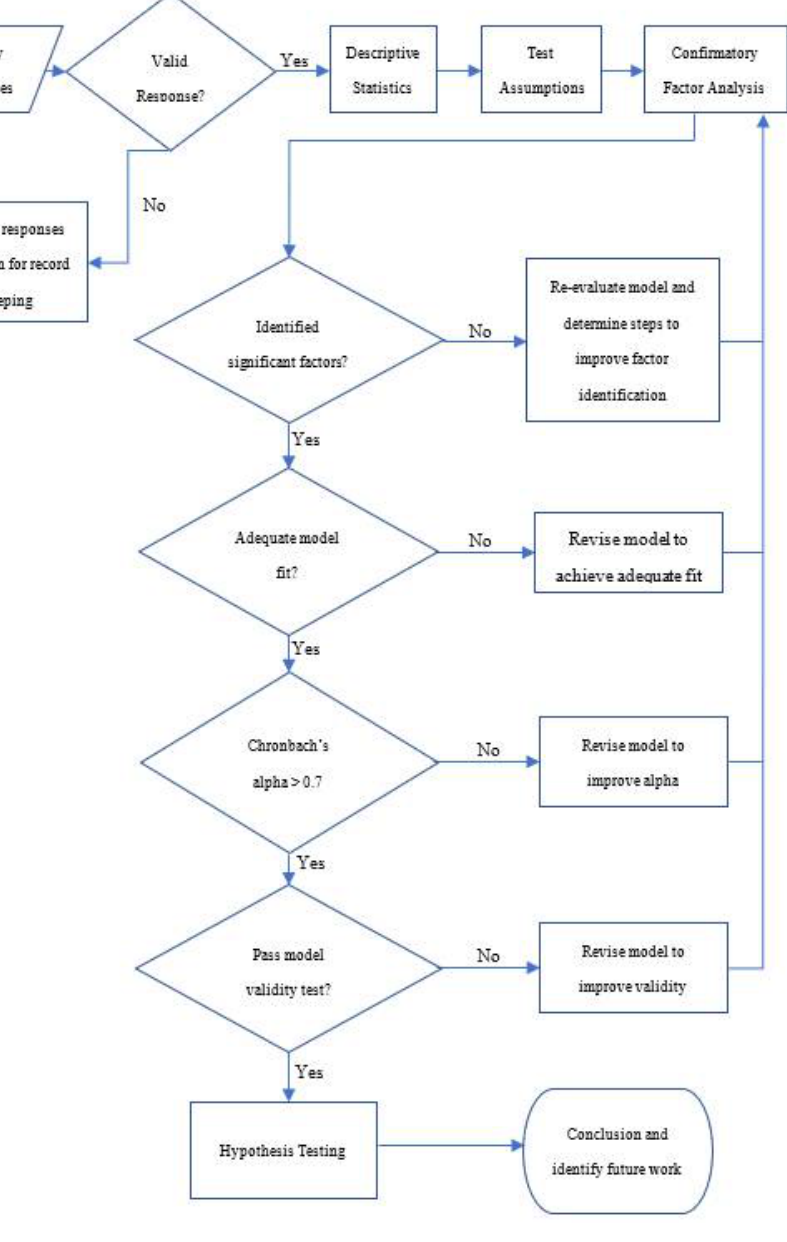
Figure 2. Survey Data Analysis Process.